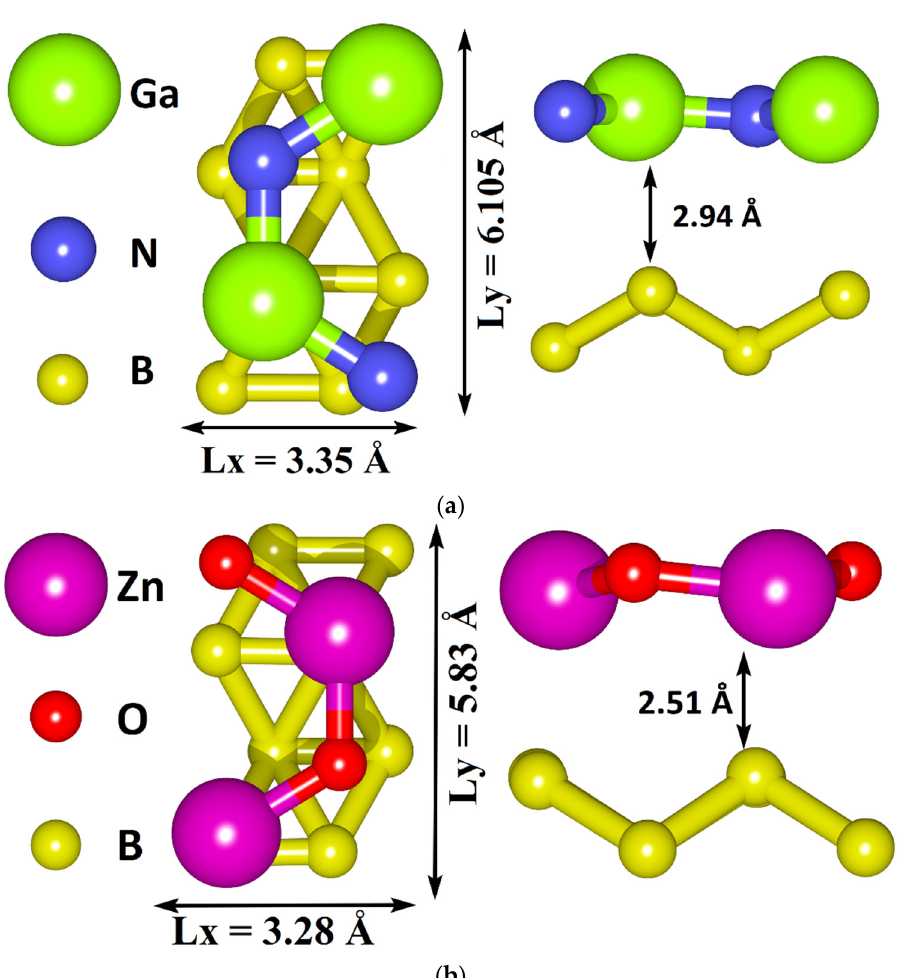
Figure 1. Thermodynamically stable supercells of borophene/GaN ( a ) and borophene/ZnO ( b ) van der Waals heterostructures.